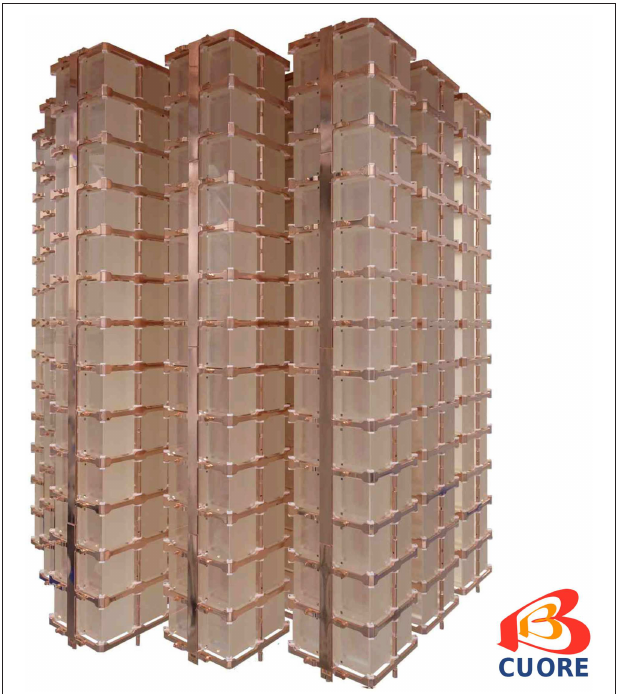
FIGURE 3 | The CUORE detector with the experiment logo. Reproduced with permission from the CUORE Collaboration. See original in the official CUORE experiment website. Available online at: https://cuore.lngs.infn.it/en.